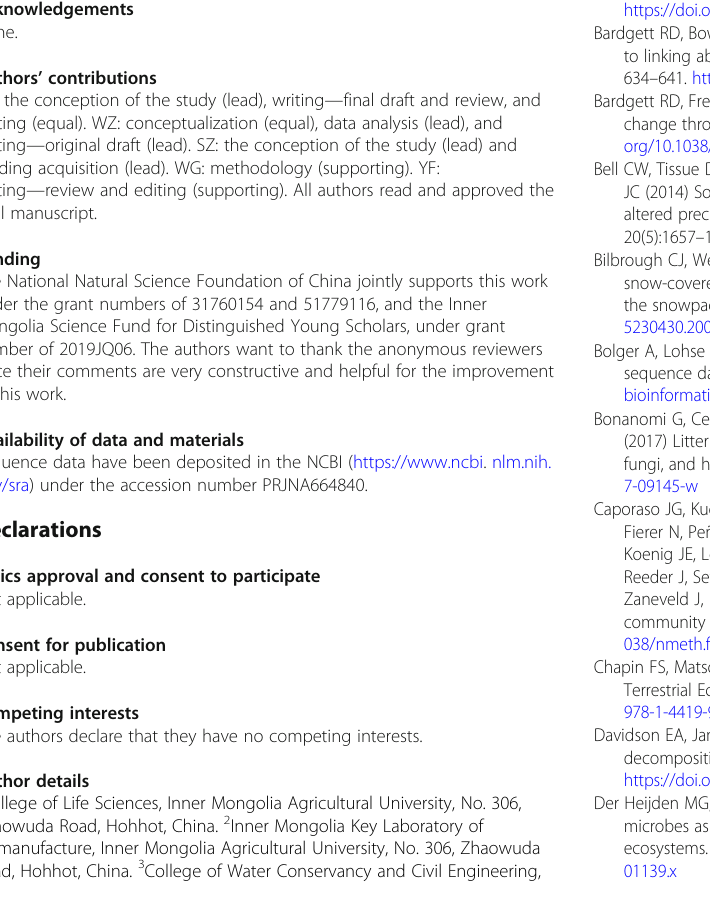
Additional file 2: Figure S2 . The variations in relative abundance of dominant bacterial and fungal phyla with depth. (A) and (B) represent bacteria and fungi. May, Jun, Jul, Aug, Sep respectively represent different months of the growing season, namely May, June, July, August and Additional file 3: Figure S3 . PERMANOVA analysis of soil bacterial and fungal communities based on the Bray-Curtis distance algorithm. (A) and (B) represent bacteria and fungi at different soil depths; (C) and (D) repre- sent bacteria and fungi in different months. Sitting vertically means Beta distance. The box graph above “ All between group ” represents the Beta distance data of all samples between groups, and the box graphs below are the Beta distance data between samples within different groups. 10, 20, and 30 represent 10 cm, 20 cm, and 30 cm of soil depths, respect- ively. May, Jun, Jul, Aug, Sep respectively represent different months of the growing season, namely May, June, July, August and September. The larger the R -value, the higher the interpretation degree of the grouping to the difference, and the greater the grouping difference. When the p - value is less than 0.05, the reliability of the test is high Additional file 4: Figure S4 . The original diagram of the structural equation model. (A) and (B) represent SEM of bacteria and fungi respectively. The structural equation model was build based on the results of Pearson correlation analysis. The results show that our observed data fit well with the bacterial ( χ 2 /df = 1.16, p = 0.280, GIF = 0.935, RMSEA = 0.042) and fungal ( χ 2 /df = 1.11, p = 0.341, GIF = 0.944, RMSEA = 0.034) models Additional file 5: Table S1 . Variations in soil properties and microbial community α -diversity index with depth and month Additional file 6: Table S2 . GLMM results showing effects of month and depth on soil properties and microbial community α -diversity